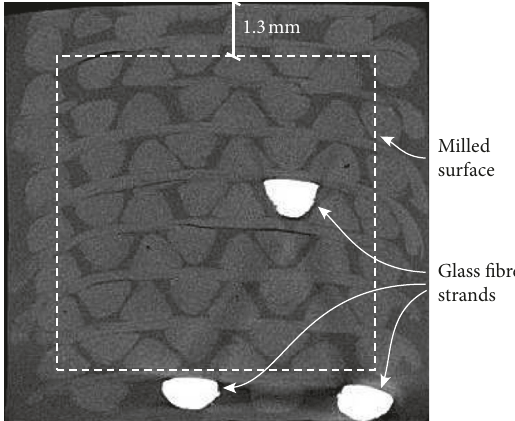
Figure 4: A CTscan image of an 8 × 8B specimen cross section. The dashed lines indicate the reduction of the cross-sectional area from milling. (Some glass fibre strands were integrated in the CT specimens, for other visualisation purposes. No glass was present in the tested specimens).